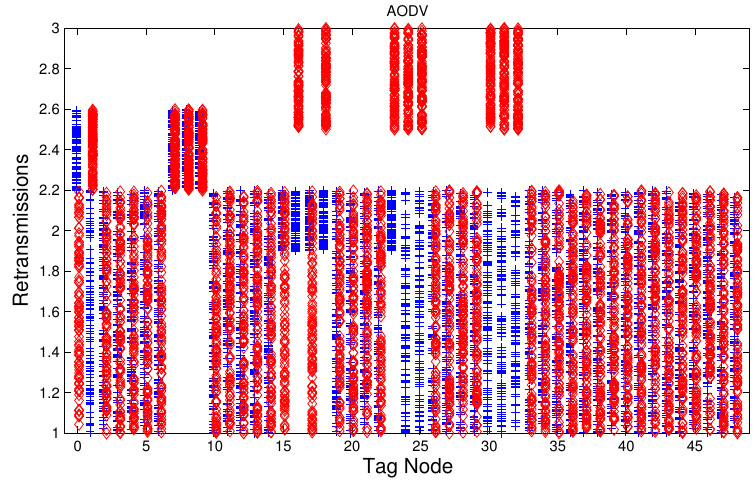
Figure 10. Average number of packet re-transmissions of the nodes from Figure 3 for AODV (Ad hoc On Demand Distance Vector) under normal (blue) and jamming (red)